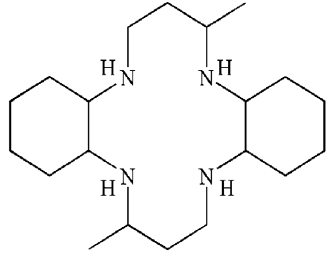
Table 1 Selected bond distances (Å) and angles ( ° ) for [Zn(L)